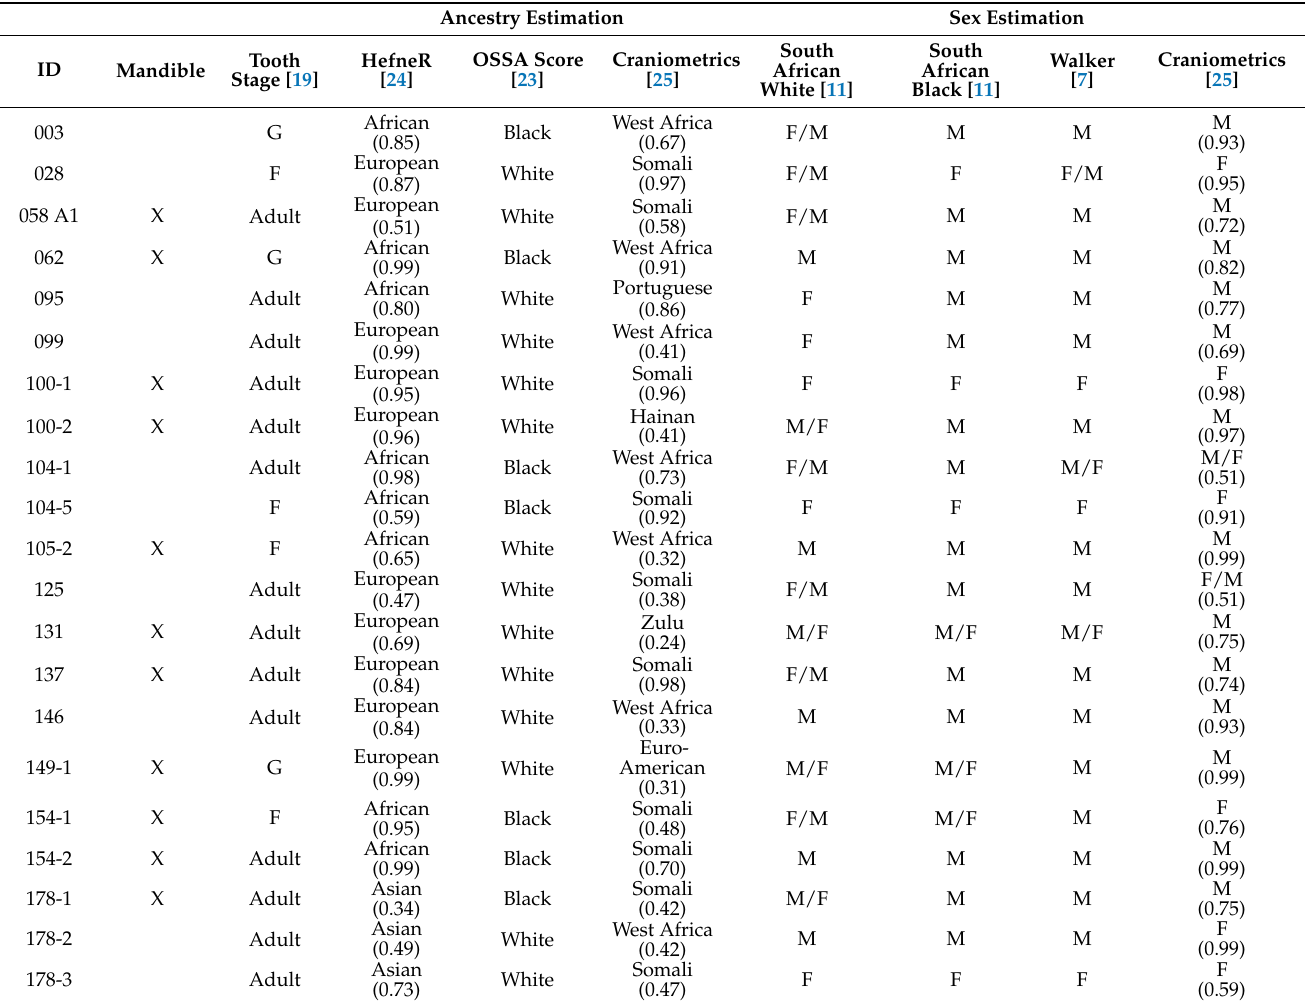
Table 1. Summary of the sex and ancestry estimation of the 21 crania. M/F, a cranium with a higher number of probabilities that classify it as male; F/M, more probabilities classify the cranium as female. In brackets is the highest posterior probability for the cranium to be assigned to an ancestral or sex